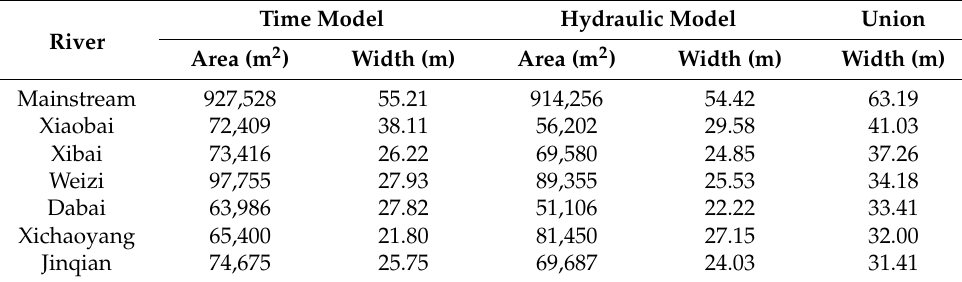
Table 4. Normal VBZ width of DX River.